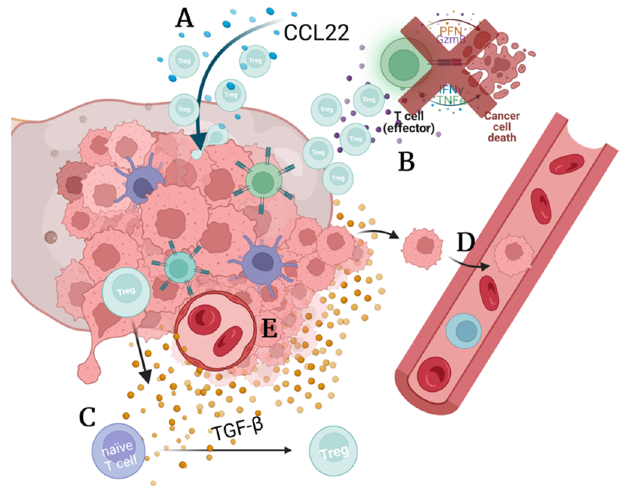
Figure 1. The action of Tregs in the ovarian cancer microenvironment. ( A ) Tumor cells may secrete CCL22 to promote Treg infiltration [4]. ( B ) Tregs in the tumor microenvironment prevent the anti- cancer immunity and allow immune escape by inhibiting the secretion of inflammatory cytokines IFN- γ and IL-2 by effector cells [4]. ( C ) Tumors may secrete TGF- β that aids in differentiating naïve T cells into Tregs, which contribute to immune suppression [16]. ( D ) Metastasis is also increased by TGF- β as it promotes EMT [17]. ( E ) Angiogenesis occurs due to upregulation of TGF- β and IL-8 [17,18].